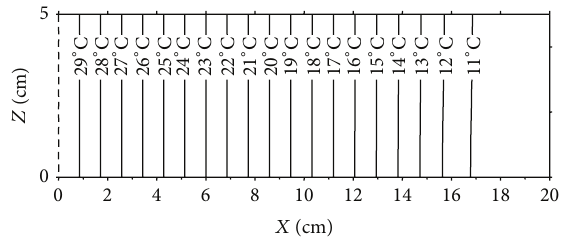
Figure 11: Distribution of liquid mass flow (in kg/m 2 ⋅ s) for 𝑡 = 135 days.